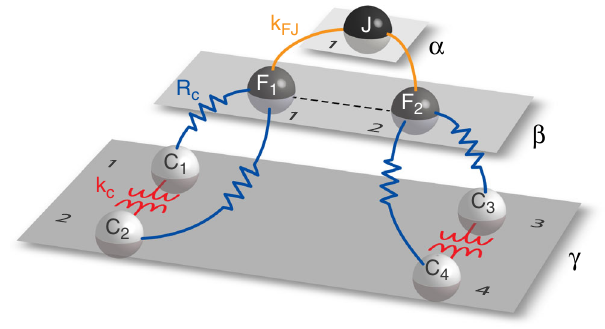
Fig. 4 Multilayer representation of the experimental circuit. Layer α contains the jumper node. Layer β contains two FHN oscillators. Layer γ contains four Colpitts oscillators with inductive intralayer coupling shown in red. The interlayer resistive coupling between the β and γ layers is shown in blue. The interlayer inductive coupling between the α and β layers is shown in orange; this coupling introduces a virtual FHN intralayer coupling which we discuss in the analysis of the